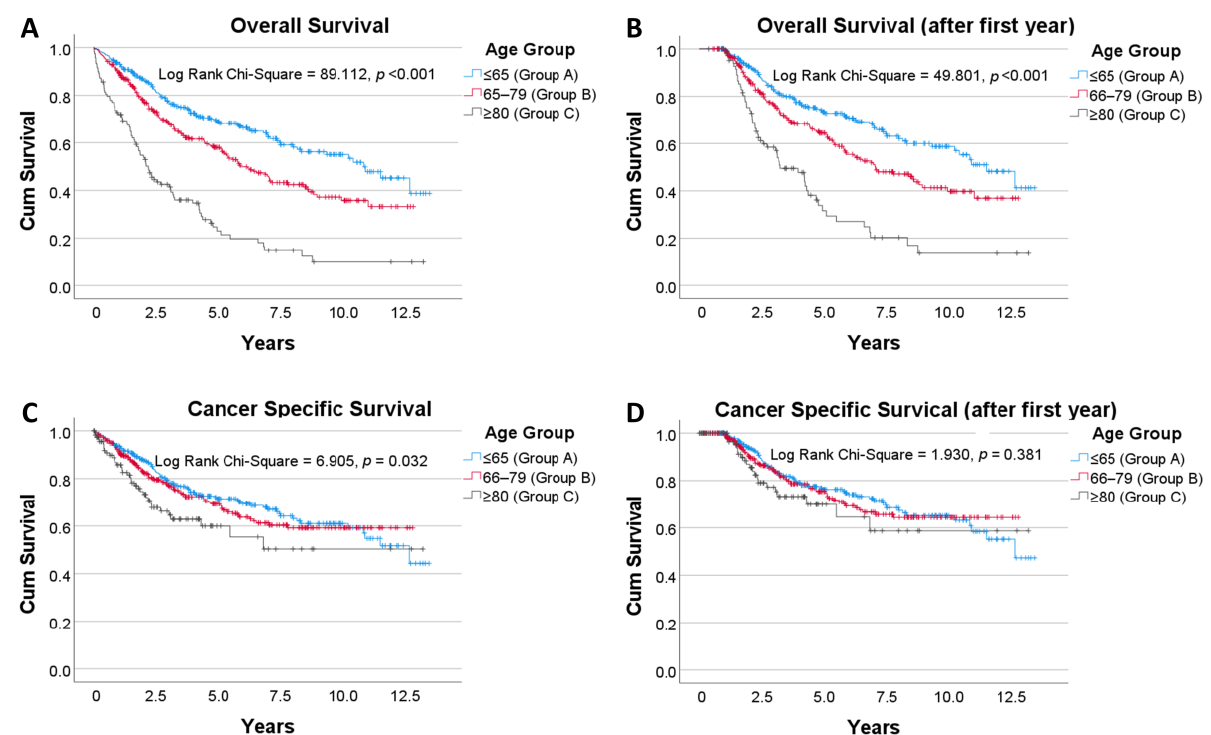
Figure 2. Kaplan–Meier analyses by age group. Above analyses included all patients, regardless of whether or not they underwent surgery ( A ): Overall survival. ( B ): Overall survival where deaths in the first year after diagnosis are excluded. ( C ): Cancer specific survival. ( D ): Cancer specific survival where deaths in the first year after diagnosis are excluded. Vertical tick marks along each survival curve indicate censorship—i.e., the last follow up where the patient was